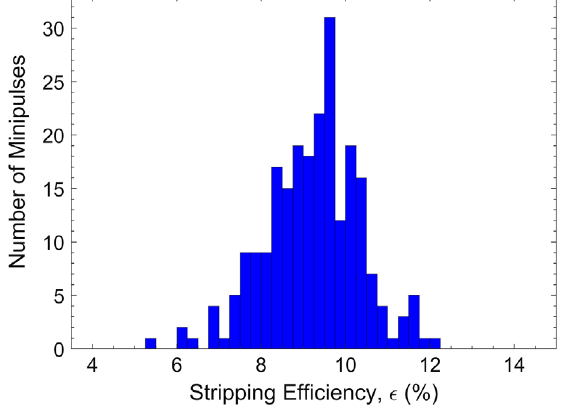
FIG. 11. A histogram of stripping efficiency distribution for multiple beam